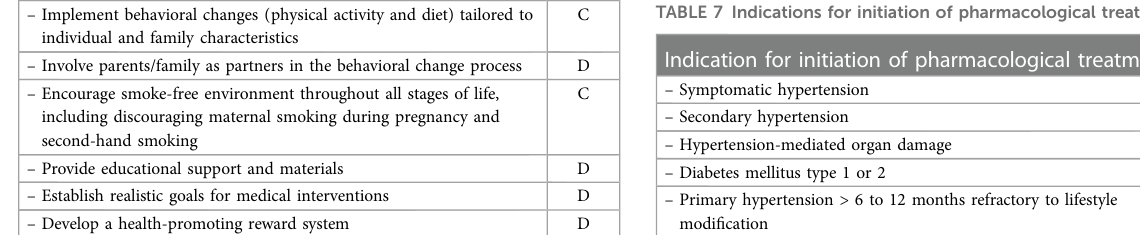
TABLE 7 Indications for initiation of pharmacological